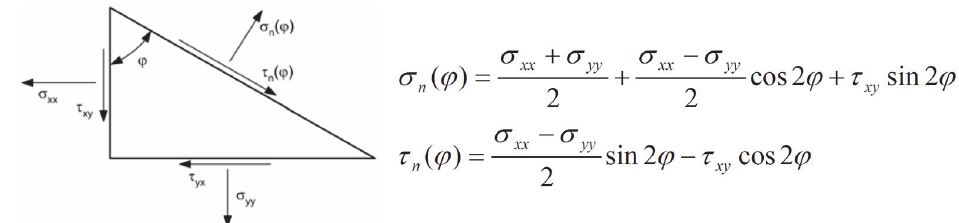
Figure 5. Evaluation of normal and shear stress in critical